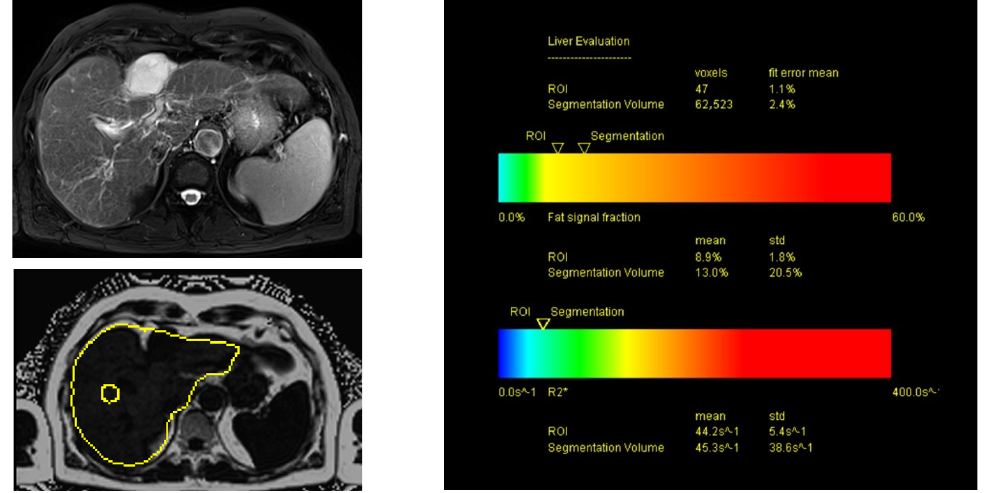
Figure 4. MRI T2-weighted (left upper image, T2 BLADE (fs)) and PDFF mapping (left lower image) in axial view in a patient with hepatic steatosis and initial fibrosis. The fat signal fraction inside the manually placed ROI (yellow circle in left lower image) showed a mean of 8.9%, consistent with mild to moderate hepatic